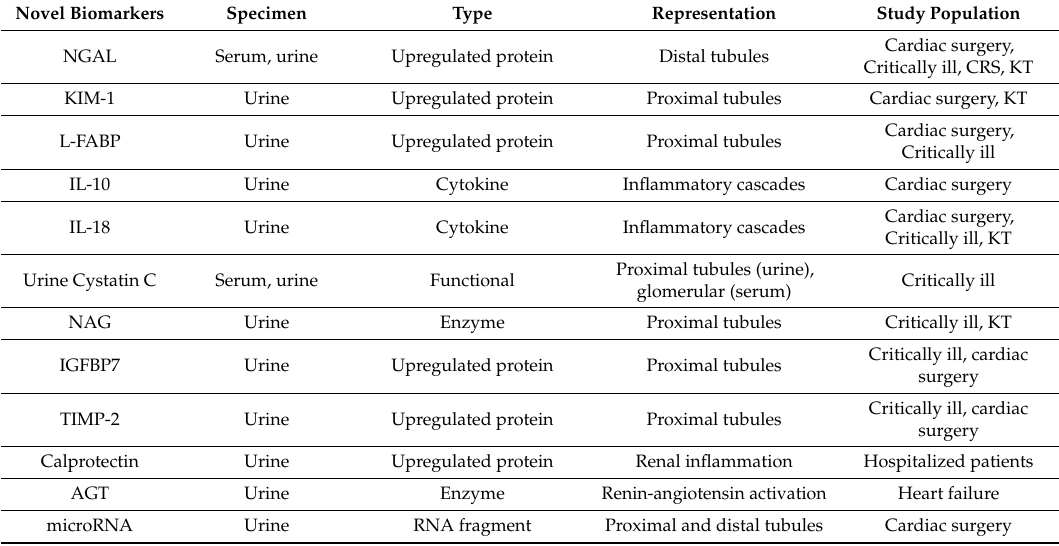
Table 4. Characteristics of selected novel biomarkers for acute kidney injury